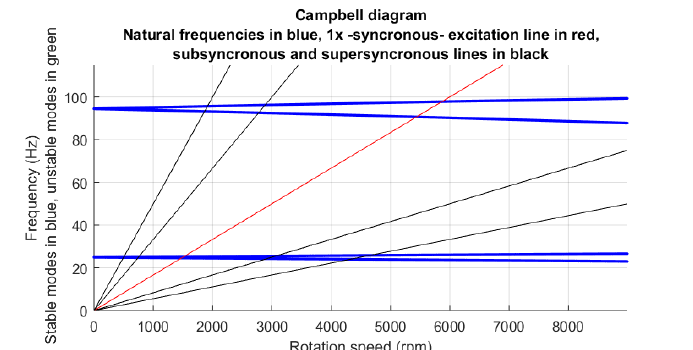
Figure 6. Campbell diagram of the two first rotor natural modes. The two bending modes split with increasing rotation speed due to the gyroscopic effect. The intersections of the 1 × line with the natural modes mark the resonance or critical speeds of the rotor. All represented modes are